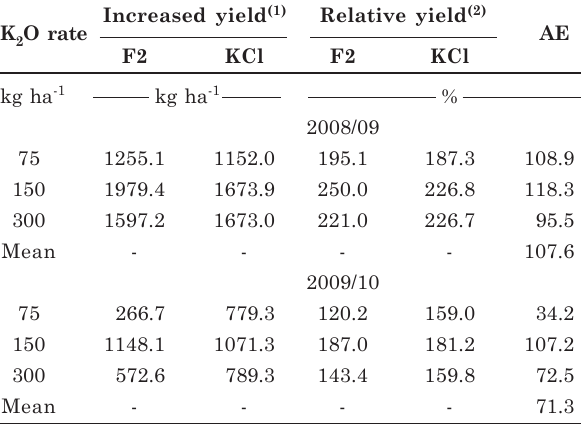
Table 2. Effect of K fertilizer source × rate interaction on Si leaf concentration of Arabica coffee, in the 2008/ 09 growing season